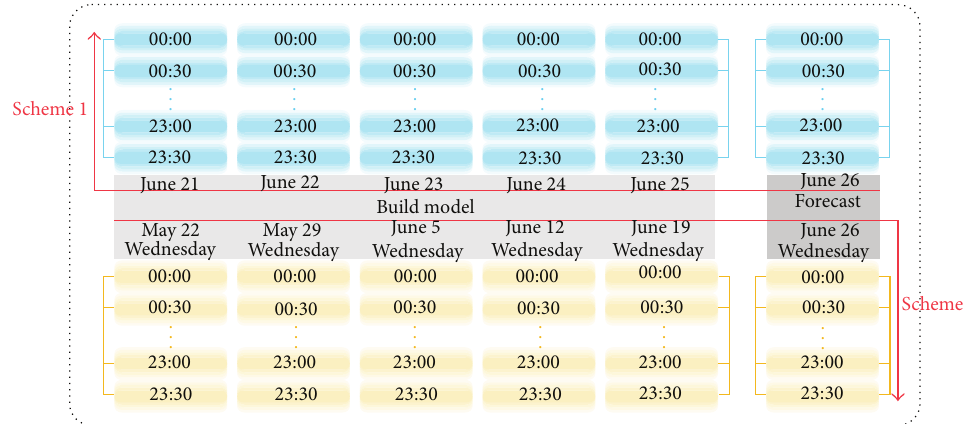
Figure 3: The data format for Scheme 1 and Scheme